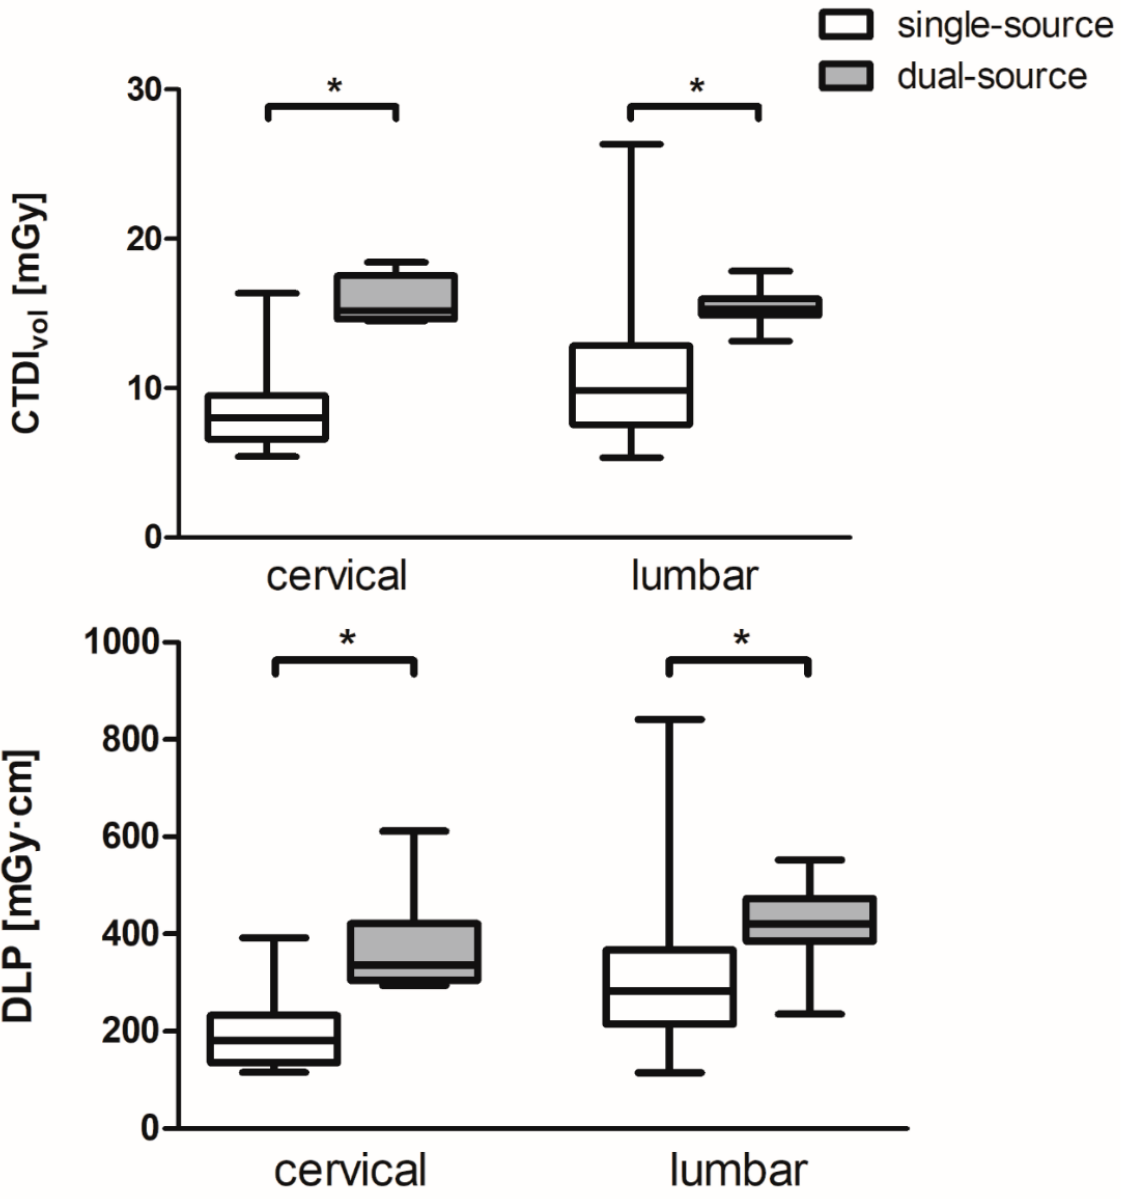
Figure 3. Comparison of radiation exposure in terms of volume-weighted CT dose index (CTDI vol ) and dose-length product (DLP) for single- and dual-source CT myelography of the cervical and lumbar spine. An asterisk (*) indicates a significant difference.